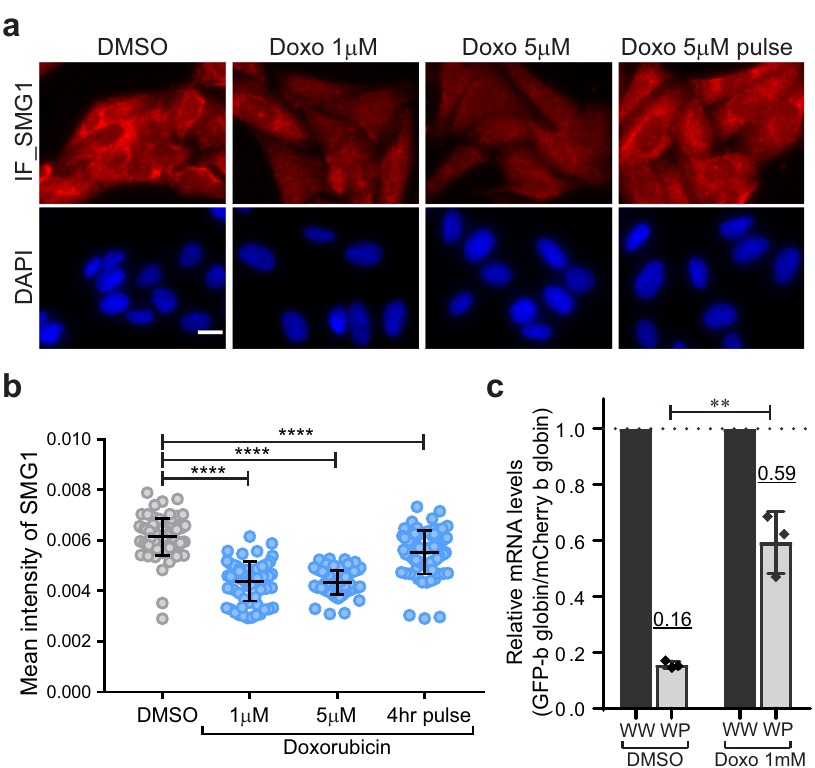
Fig. 4 SMG1 is decreased by a DNA damage inducer. a SMG1 detection in U2OS cells by immuno fl uorescence (IF) under the treatment of doxorubicin (Doxo). Cells were treated with doxorubicin for 24-hr with the indicated concentrations. Doxorubicin treatment was removed after 4-hr and transcription was induced with 20 nM PonA in the cells (Doxo 5 µ M pulse). SMG1 was detected by IF using anti-SMG1 antibody followed by Alexa Fluor 647 linked anti- rabbit IgG. Bar = 20 µ m. b The mean intensity of SMG1 in cytoplasm was detected in a . n cells = 82, 67, 71, 78 for DMSO, 1 uM, 5 uM, or 4-hr pulse doxorubicin treatment. b Single dots denote fl uorescence intensity of SMG1 intensity in individual cells. The mean intensity of cytoplasmic SMG1 in individual cells were determined using Cellpro fi ler software 47 – 49 . P values were determined using two-tailed unpaired t-tests (**** P < 0.0001). Error bars = Standard deviation in cell populations. c NMD ef fi ciency was determined by the quantitative mRNA detection of NMD reporter. Relative EGFP- β globin mRNA levels (Wild-type or PTC-containing β globin in WW or WP expressing cells) were determined by RT-qPCR. mCherry- β globin mRNA (wild-type β globin mRNA in each WW or WP expressing cells) was used as a control. Relative GFP- β globin mRNA levels under high concentration of doxorubicin (5 μ M) was unable to detected due to the signi fi cant reduction of reporter expression. The underlined number above the data points indicates the mean value. P values were determined using two-tailed unpaired t tests (** P = 0.0025). Error bars = Standard deviation from three independent experiments. The statistical analysis was performed by Graphpad prism cells. The mRNA levels of UPF2, UPF3A, and SMG6 did not endogenous NMD-targets in each FACS-isolated cell population correlate with NMD ef fi ciency in both cell types. The differential was assessed as a control since NMD escape may be transcript- correlation of UPF3B and SMG7 mRNA for the two cell types dependent (or reporter-dependent). Using RT-qPCR analysis, we could be explained by cell-type-speci fi c auto-regulatory feedback detected higher mRNA levels of endogenous NMD targets, except as reported previously 62 . Moreover, NMD ef fi ciency of ANTXR1 mRNA, in HEK293T ponA (Fig. 5e) and U2OS ponA